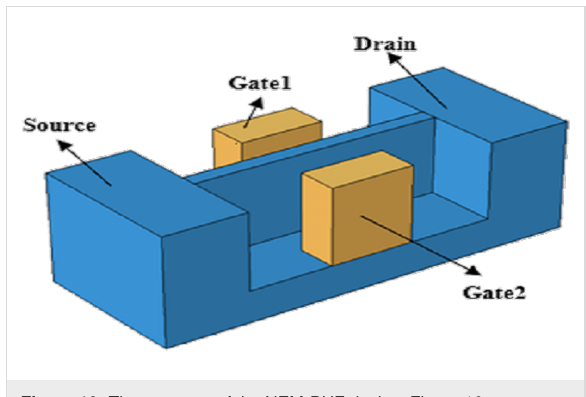
Figure 10: The structure of the NEM-PUF device. Figure 10 was redrawn from [79].